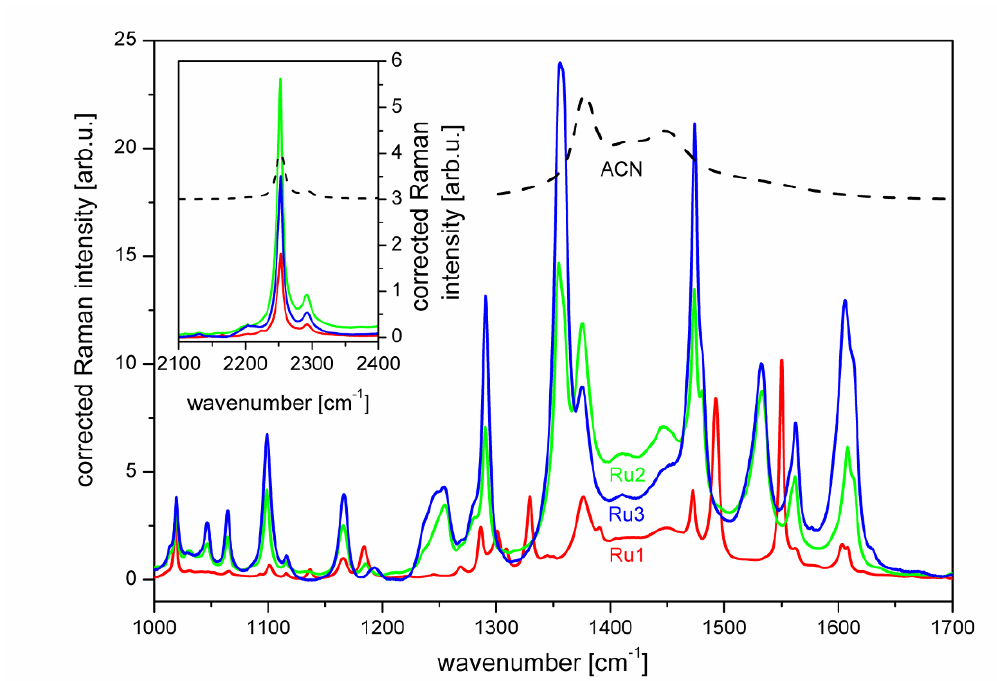
Figure 6. Resonance Raman spectra of Ru1 (red solid line), Ru2 (green solid line) and Ru3 (blue solid line) from solutions in acetonitrile (excitation at 476 nm). The non-resonant Raman spectrum of the solvent is given as reference (black dashed line, offset). The inset displays the resonance Raman spectra of Ru1–Ru3 and the nonresonant Raman spectrum of the solvent in the spectral region between 2100 and 2400 cm -1 . The spectral resolution of the spectrometer was approximated to 1 cm -1 .